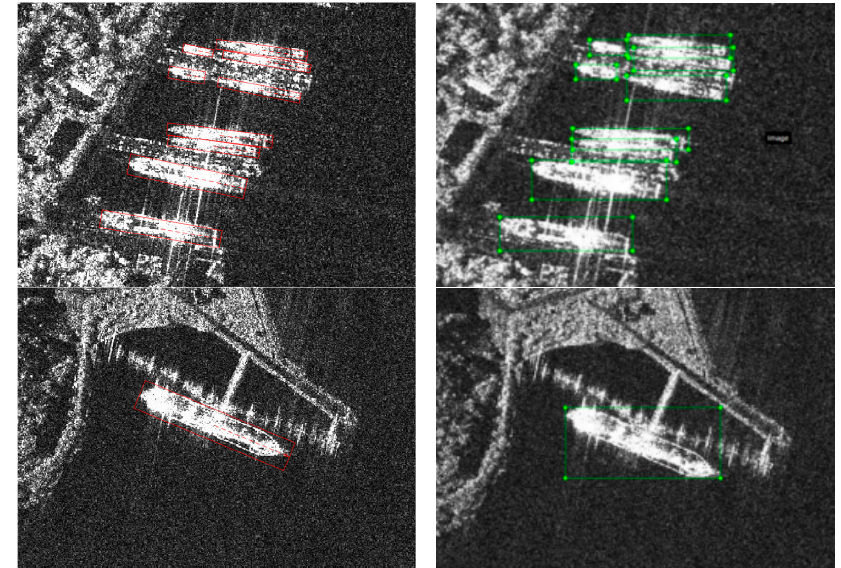
Figure 4. Comparisons between vertical bounding boxes and rotatable bounding boxes.